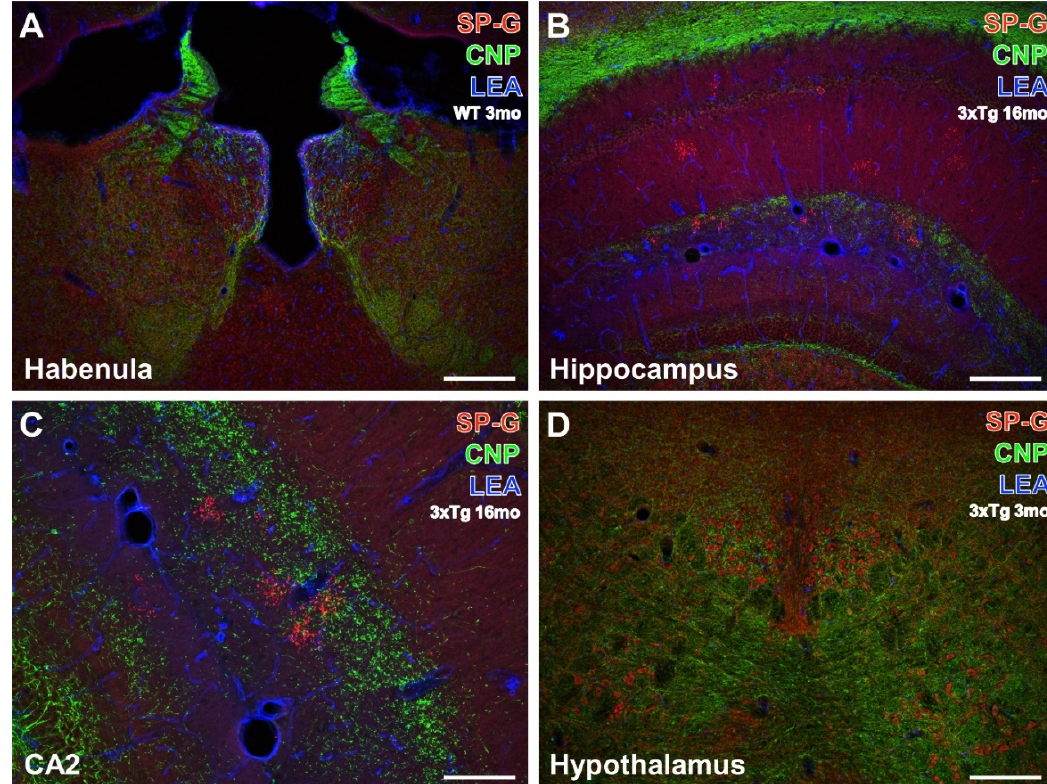
Figure 4. Concomitant fluorescence staining of SP-G, LEA-positive vessels, and oligodendroglial CNP in different forebrain regions. In ( A ), both hemispheres of the habenula from a 3 month-old WT mouse exhibit heavy SP-G labeling that appears strongest in its medial part. More ventrally and medially located intermediodorsal, lateral posterior, parafascicular nuclei, and the posterior complex of the thalamus also display numerous SP-G-containing cells. Further, the immunolabeling of CNP demonstrates many fibrous structures and is most prominent in the striae medullares but is absent in the paraventricular thalamic nucleus. Counterstaining of LEA appears strongest around the ventricle and is moderate in numerous vessels. Note the absence of structures co-expressing SP-G and CNP, as indicated by the lack of the mixed color yellow. The hippocampus of a 16 month-old 3xTg-AD mouse in ( B ) is absent from noticeable cellular SP-G-ir but the neuropil of the gyrus dentatus and strata lacunosum-moleculare and radiatum are faintly stained. In contrast, the strata oriens, lacunosum-moleculare, and radiatum of the CA1 field, as well as the granular layer of the dentate gyrus, contain numerous clusters of SP-G-immunopositive dots. CNP counterstaining reveals massively labeled white matter as well as weaker stained fine processes of the granular layer and coarser structures in the dentate gyrus—intermingled by SP-G-dots and bordered by vessels of the LEA-positive fissura hippocampalis. At a higher magnification, the hippocampal CA2 region from the same old transgenic animal ( C ) shows largely the same spatial relationships between the stained markers as ( B ). Similarly, the lower magnified hypothalamus of a 3 month-old 3xTg-AD mouse ( D ) exhibits SP-G-ir of cells embedded within CNP-immunoreactive processes without co-labeling of both markers in the posterior hypothalamic nucleus. Scale bars: C = 100 µm, D (also valid for A , B ) = 200 µm.